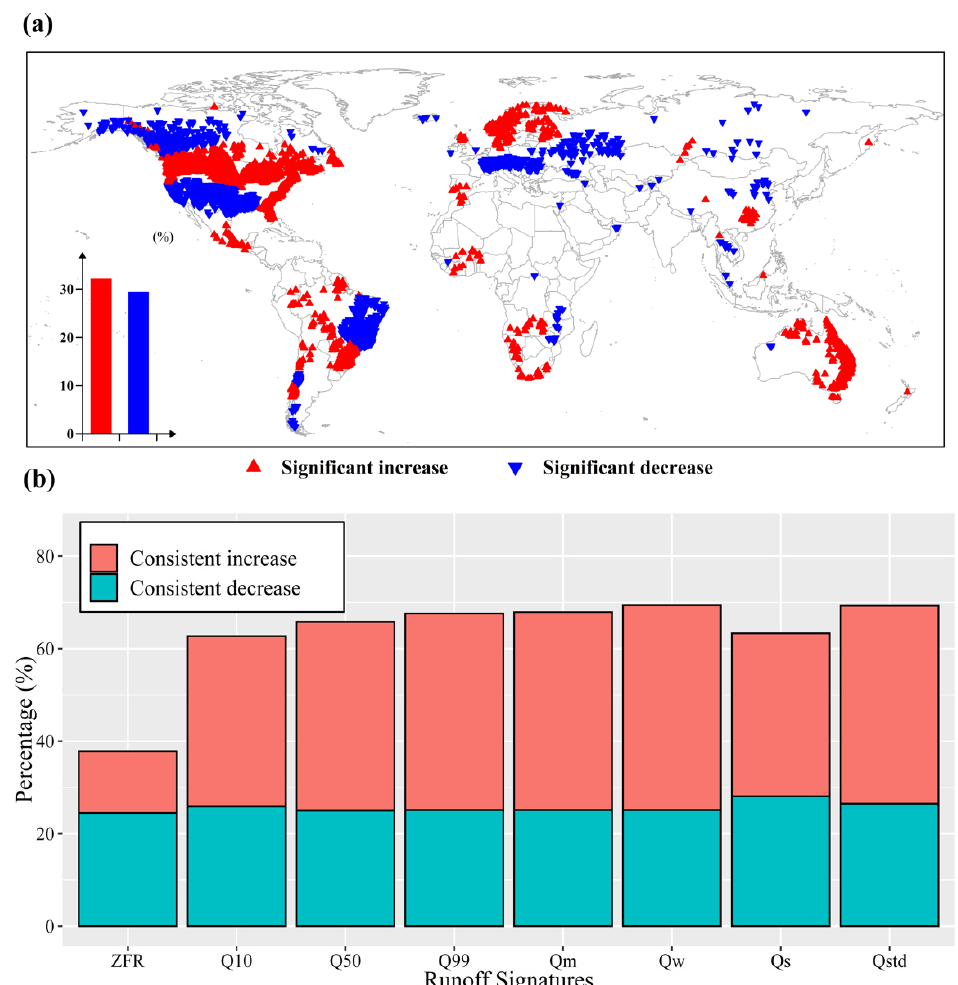
Figure 6. ( a ) Spatial patterns of trends in TWSA based on the Mann–Kendall test at the 0.05 significance level (1979~2017). The red (blue) triangle represents a significant increase (decrease). The bar chart shows the percentages of stations showing significant trends. ( b ) The percentage of stations with consistent increase/decrease in TWSA and eight RS. Red (blue) indicates the proportion of stations with consistent increase (decrease) in TWSA and RS.